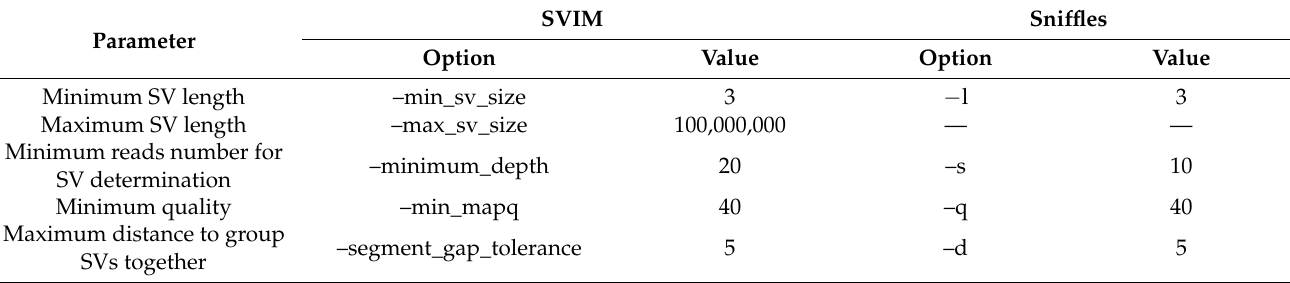
Table 1. Summary of the quality table of the obtained